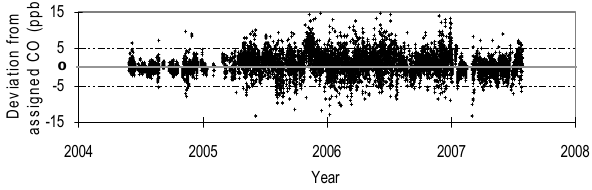
Fig. 2. Deviation of CO mixing ratios for target gases from their assigned